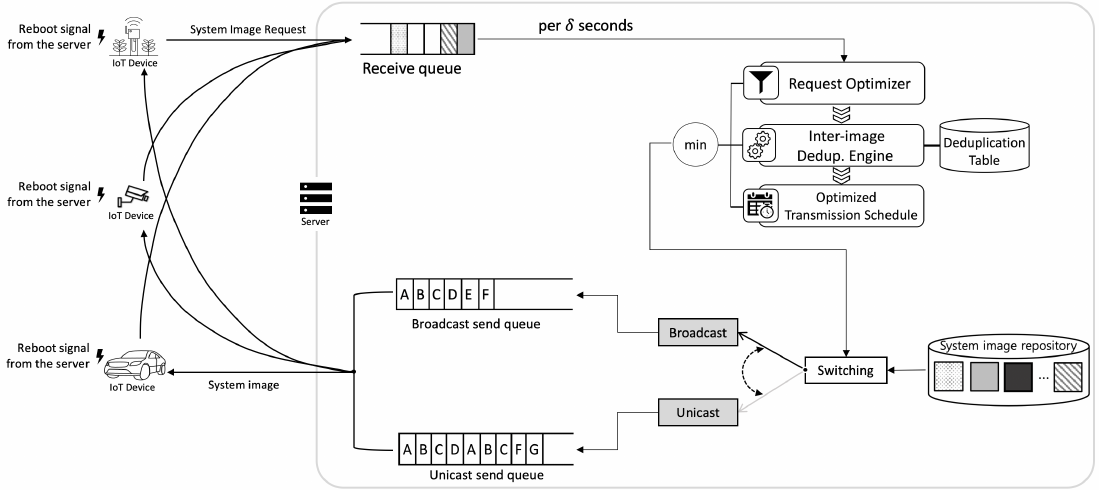
Figure 3. Adaptive